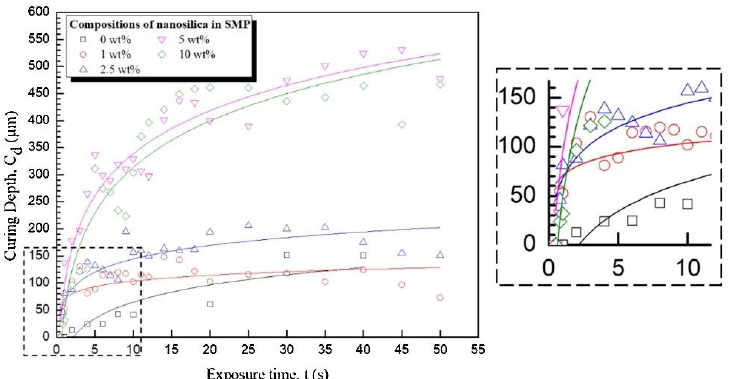
Figure 16. Curing depth versus exposure time of nanosilica/acrylic-based resin [63]. Copyright © 2022 Elsevier.